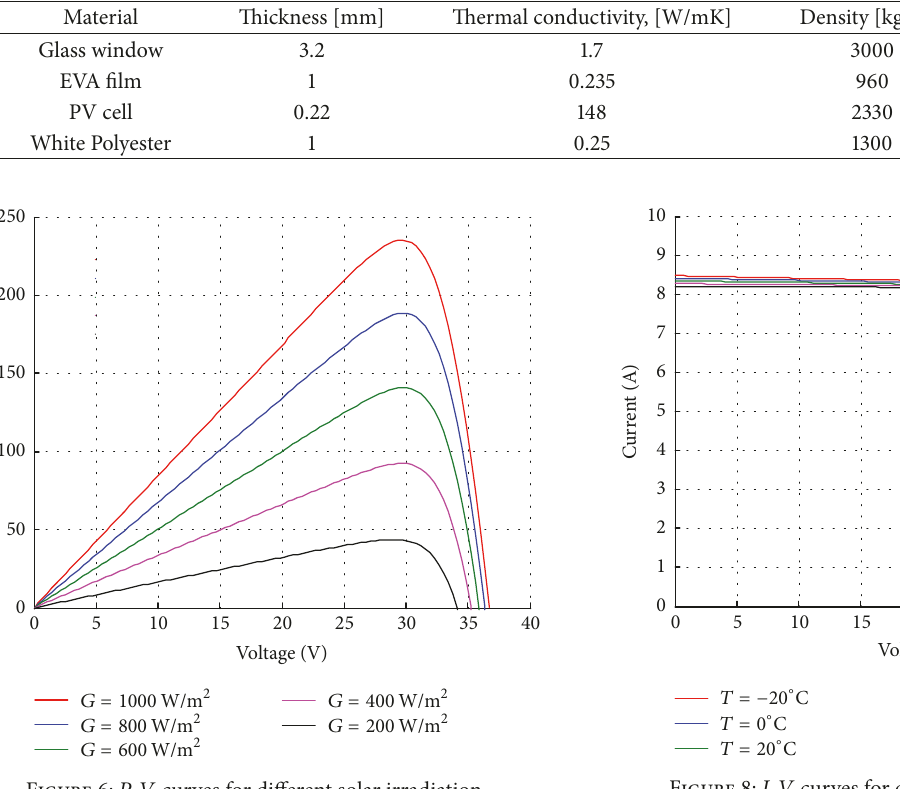
Figure 6: 𝑃 - 𝑉 curves for different solar irradiation.